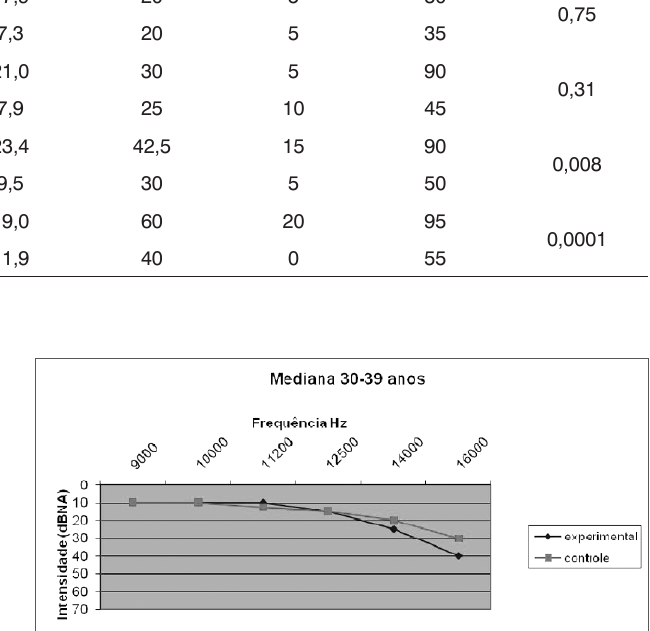
B razilian J ournal of o torhinolaryngology 76 (6) n ovemBro /D ezemBro 2010 http://www.bjorl.org.br / e-mail: revista@aborlccf.org.br